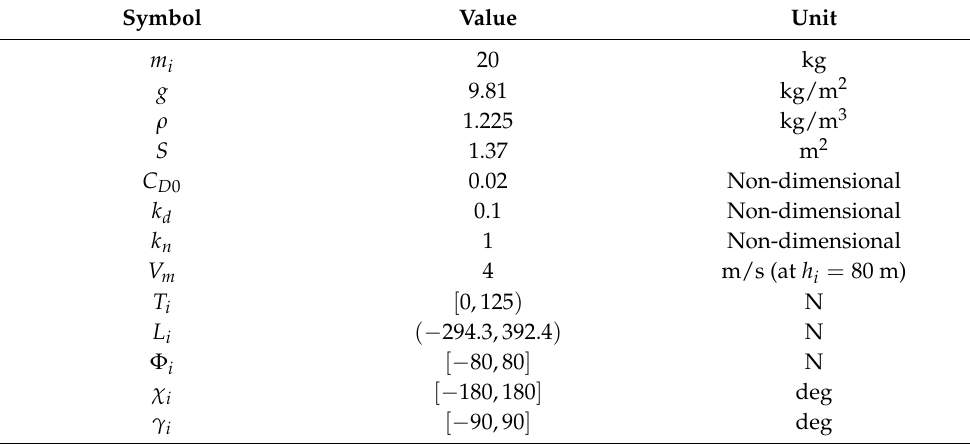
Table 1. Settings of UAV Parameters.